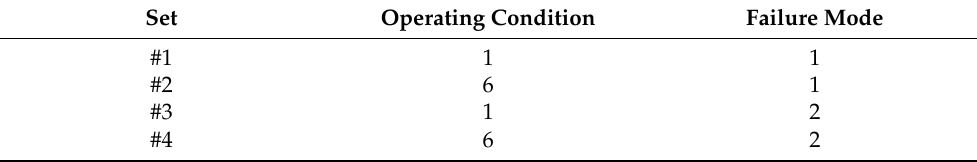
Table 1. The information of operating condition and failure mode simulated by each set of data.